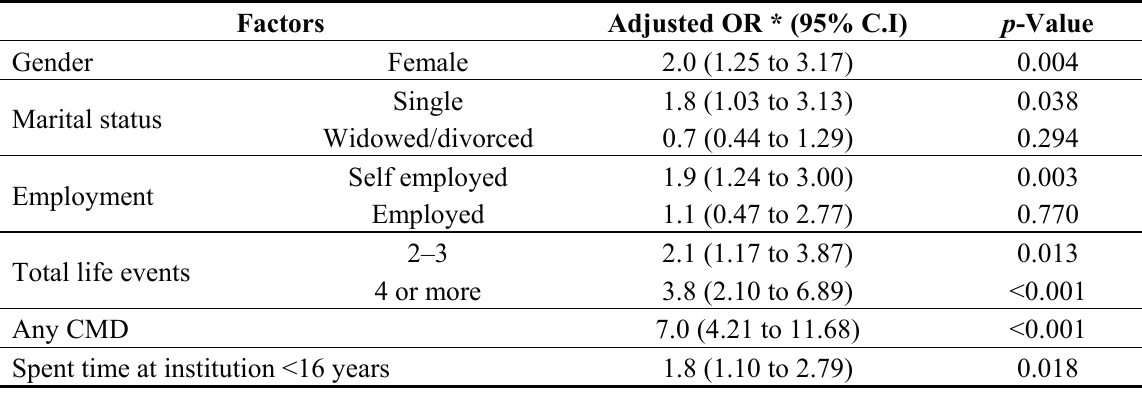
Table 3. The final adjusted model risk factors for PTSD, using multivariate logistic regression analysis (adjusted odds ratios).